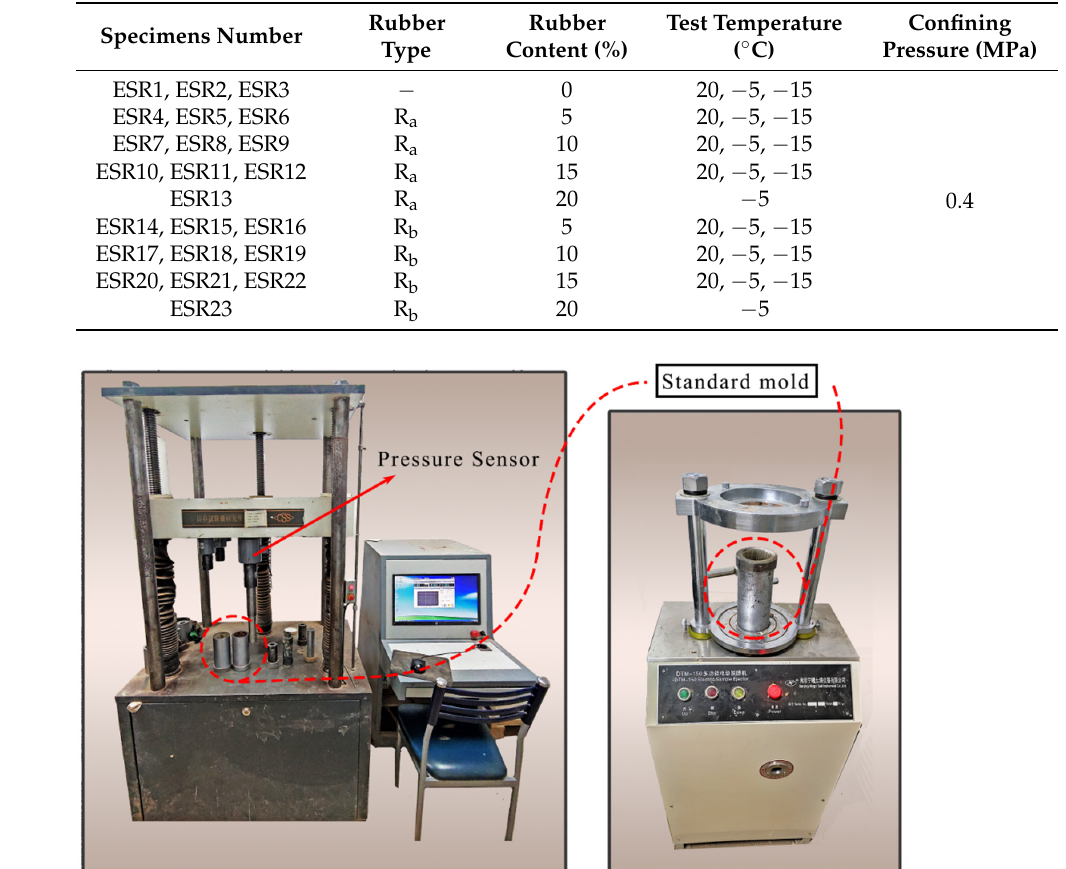
Table 2. Specimens’ parameters for ESR test.